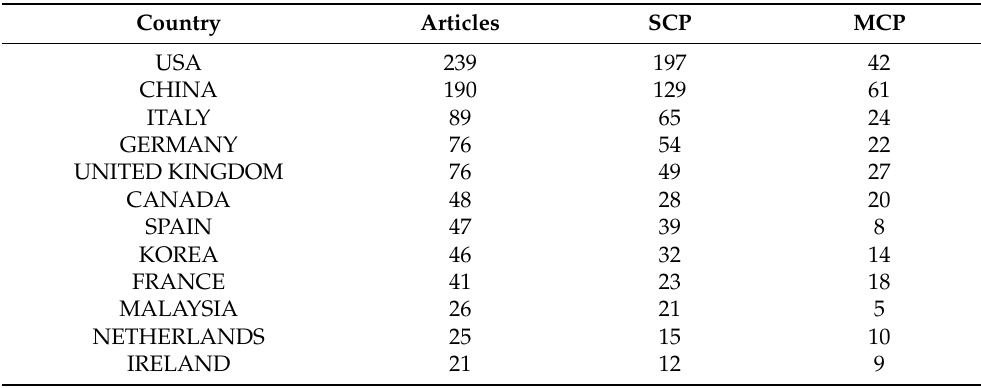
Table 7. The collaboration of